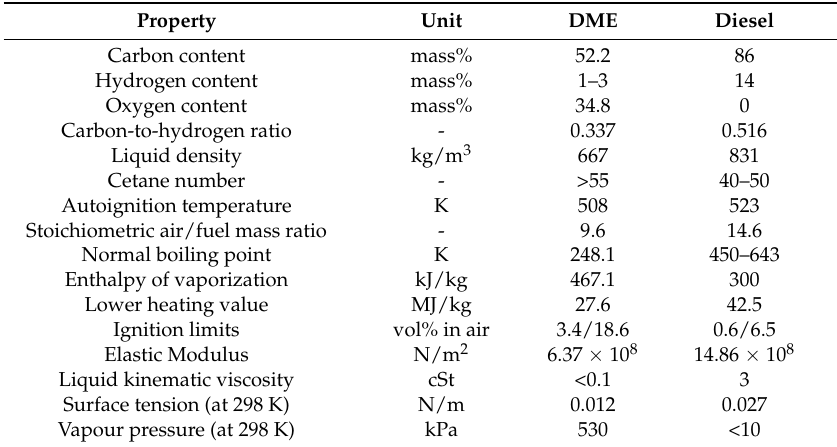
Table 1. Physicochemical properties of DME and diesel fuels